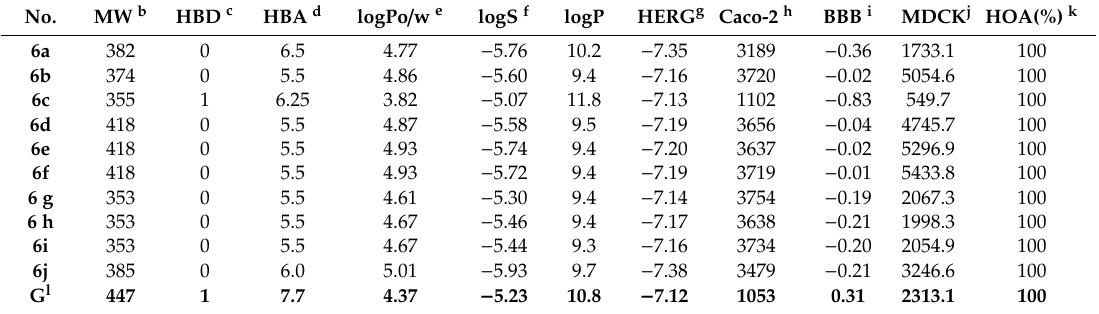
Table 2. Analysis of drug likeness properties and pharmacokinetic properties by QikProp for 6a – j. No. MW b HBD c HBA d logPo / w